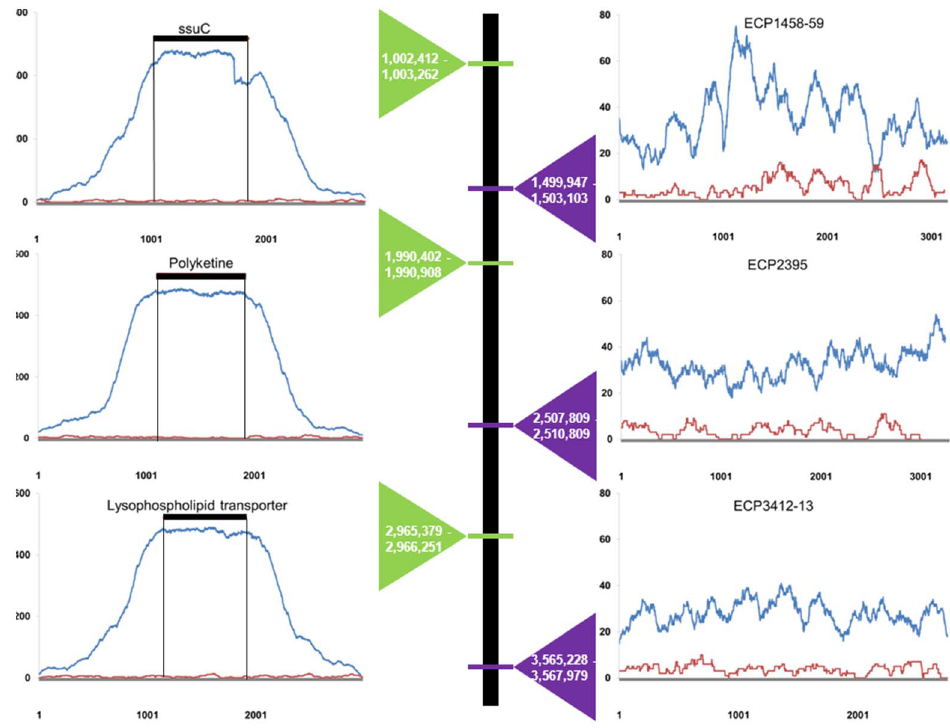
Figure 4. CapFlank can capture sequences thousands to millions of bases away from the bait region. Five ca. 1 kb baits spaced approximately 1 Mb apart were used to capture E. coli strain 536 from DNA extracted from human urine. Bait regions for 3 of the 5 baits employed with 1 kb of sequence 5 9 and 3 9 of the bait are shown on the left and non-targeted bacterial regions are shown on the right. Positions of the baits and genes are indicated above the covered positions by name and with a black line covering the length of the bait and the ends marked with vertical black lines. The y axis represents per base coverage and the x axis position. As per base coverage varied, the scales in each panel are not identical. Relative positions of the targeted genes are shown in order along the bacterial genome and the positions are shown within the triangles (green triangles targeted regions, purple non-targeted). Within each graph mapped reads for bacterial targeted hybridization capture and bacterial capture with KoRV are compared (blue and red lines respectively).